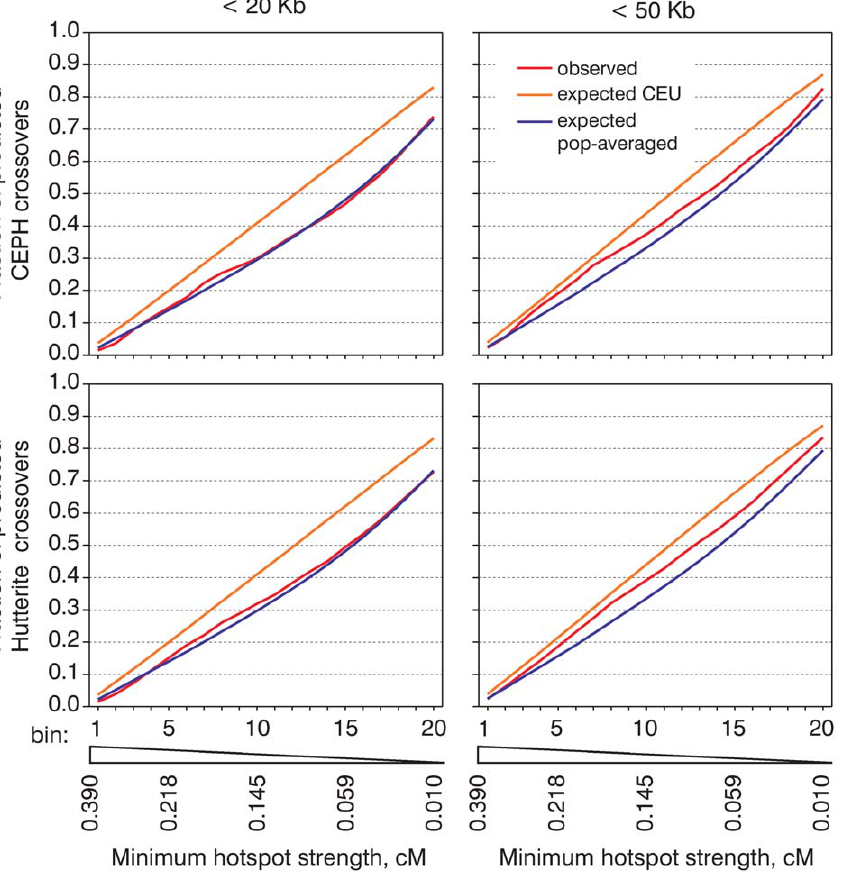
Figure 3. The population averaged map is much closer to the distribution of meiotic crossovers than the CEU map. We calculated and plotted cumulative recombination frequency graphs for CEPH (A) and Hutterite (B) crossovers and the cumulative recombination frequency graphs for crossovers re-distributed according to the population-averaged or CEU maps.